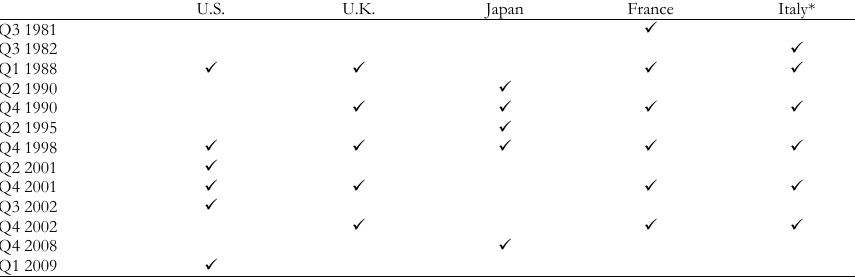
Identification of the quarters of financial turmoil (standardized X i,t < -2)